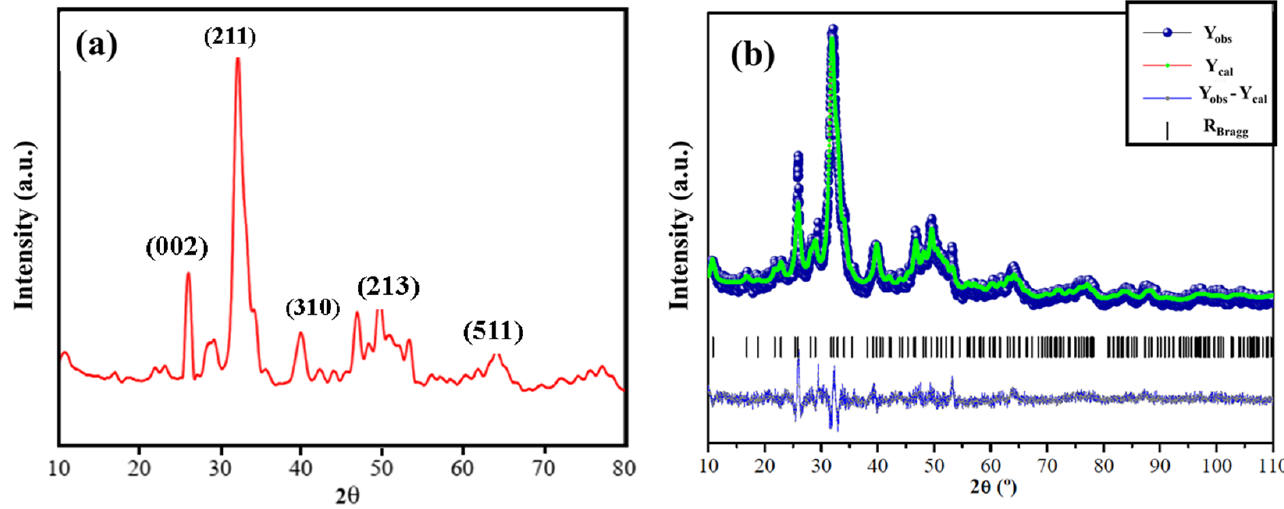
Figure 1. ( a ) XRD pattern for the ( a ) Ga-HAp powders synthesized by the suspension–precipitation method (SPM) and Rietveld refinement profiles ( b ) from XRD data for Ga ‐ HAp.